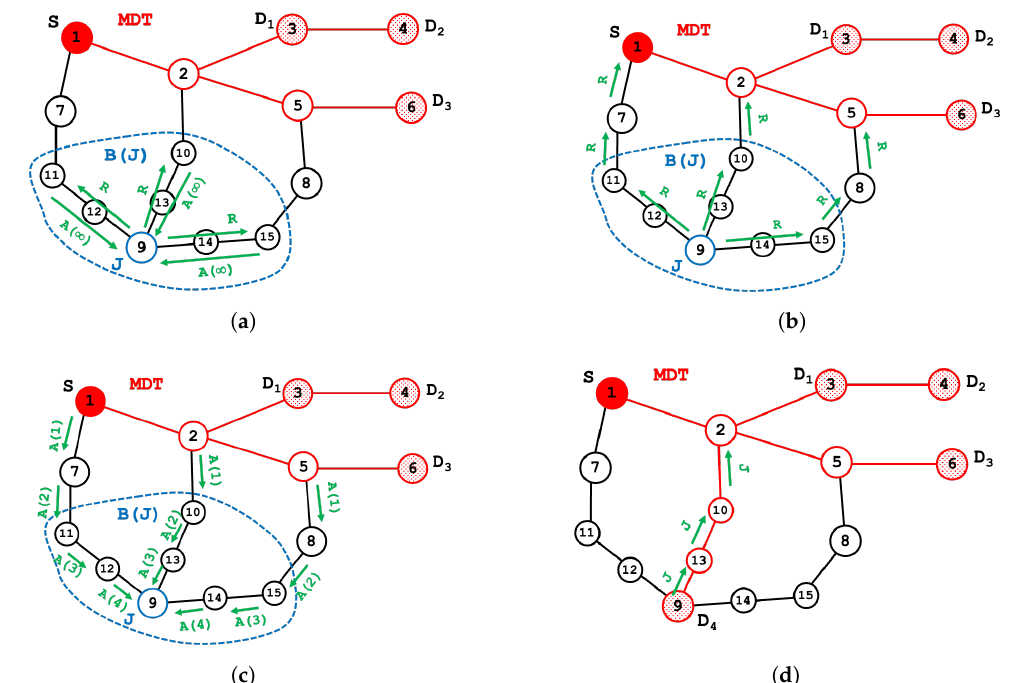
Figure 3. Creation of a branching path between a joining node and the MDT using global search: ( a ) local search fails to find a node of the MDT in B ( J ) ; ( b ) joining node J searching messages outside B ( J ) ; ( c ) nodes’ answers to the joining node; ( d ) node joins the MDT through the least cost branching